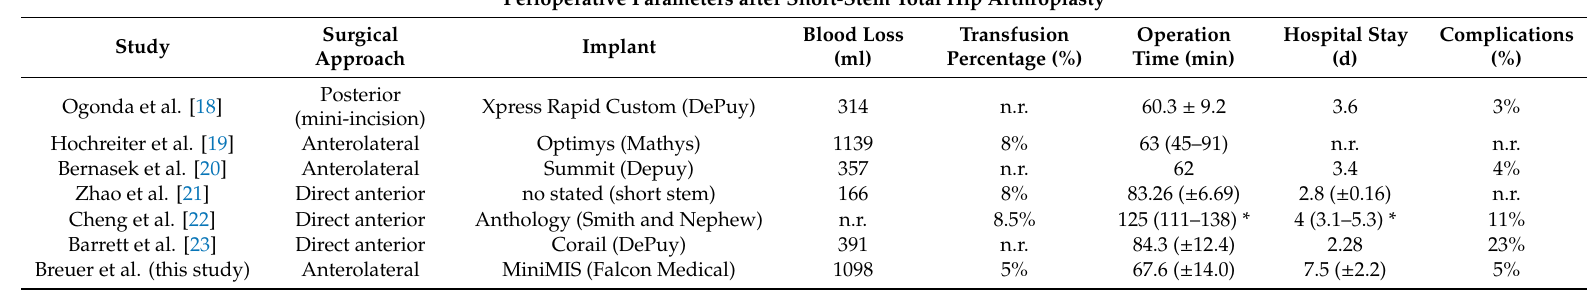
Table 3. Perioperative parameters after short-stem total hip arthroplasty. Overview of current literature. Values are depicted as arithmetic mean and standard deviation unless marked otherwise. * Values depicted as median and